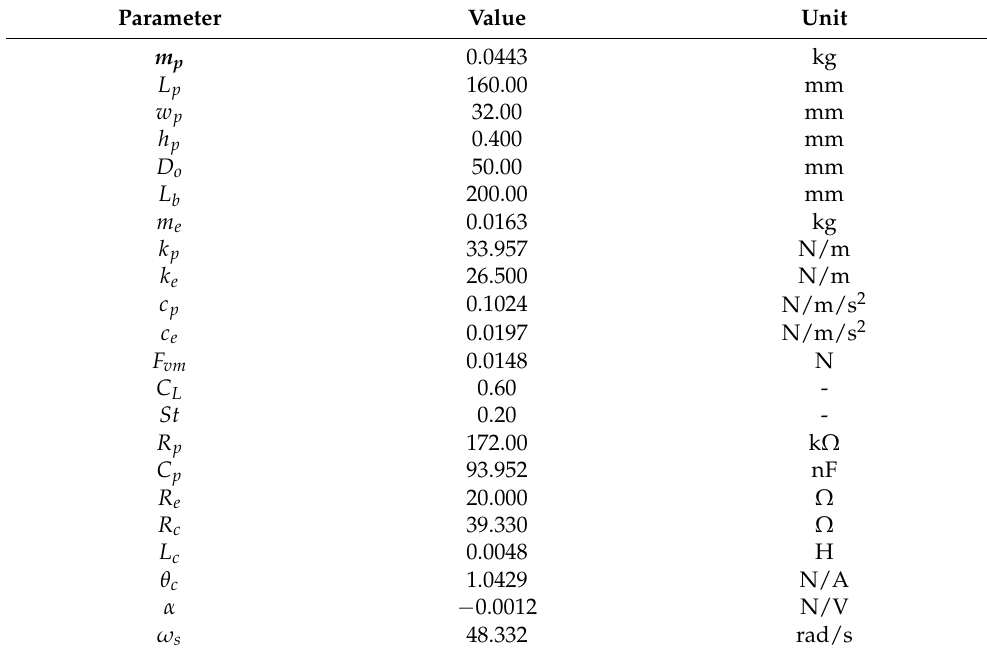
Table 1. Nominal parameters of the harvester used in this